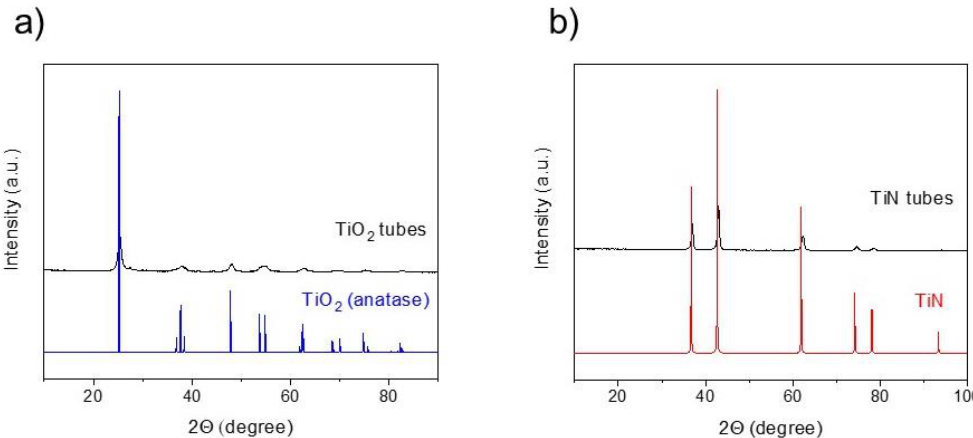
Figure 1. X-ray diffraction (XRD) patterns of ( a ) TiO 2 tubes and ( b ) TiN tubes.